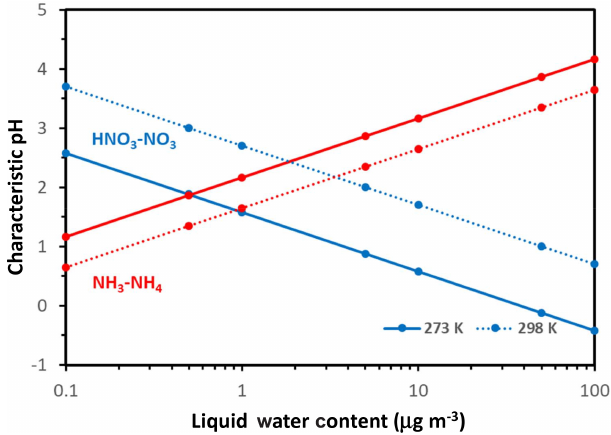
Figure 2. Characteristic pH for defining when aerosol is sensitive to changes in available nitrate (blue lines) and ammonia (red lines) versus W i . Results shown for a temperature of 298K (dotted line) and 273K (solid line). Note the relatively stronger effects of tem- perature changes on the characteristic pH for nitrate. Calculations were carried out using the Excel spreadsheet provided in the Sup-